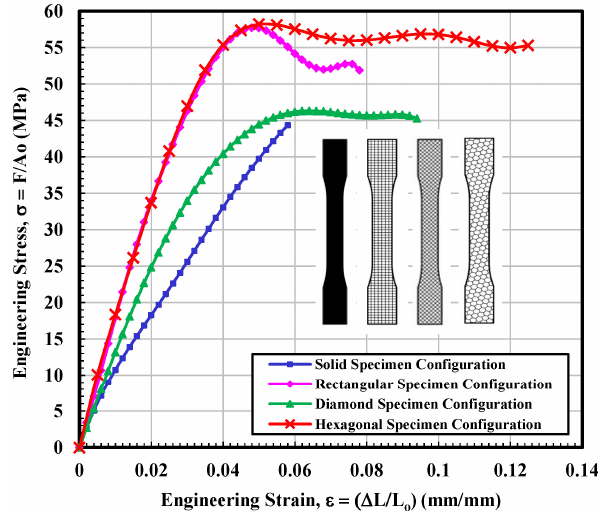
Figure 9. Average engineering stress–strain curves for solid, rectangular, diamond, and hexagonal infill test specimen configurations based on three tensile test specimens.